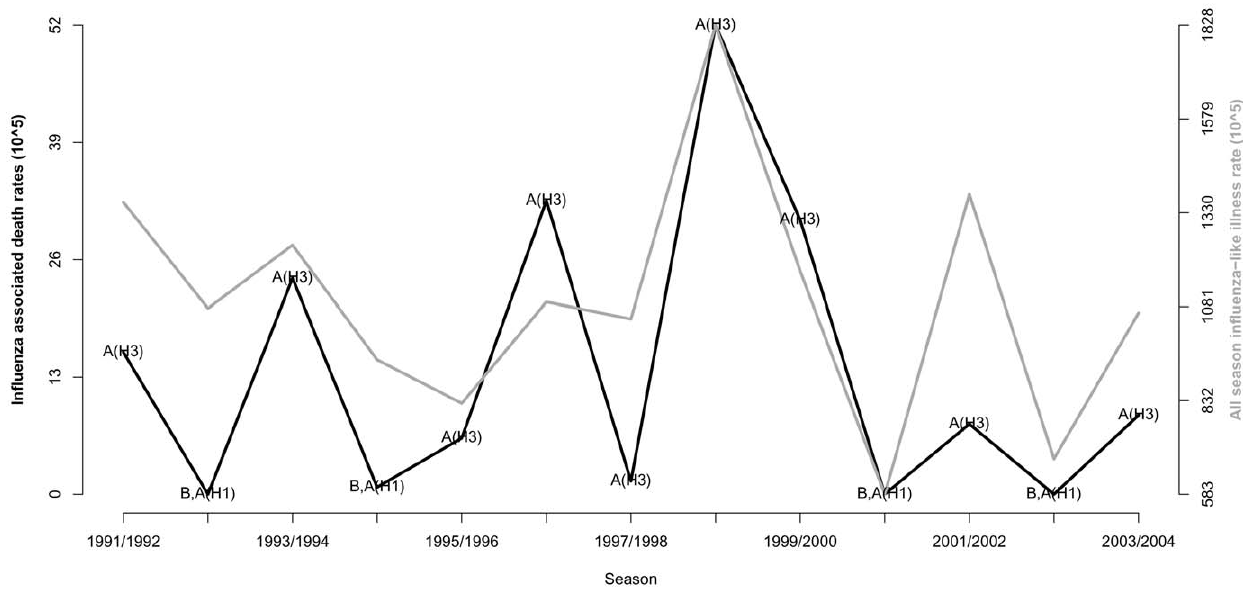
Figure 3. Association between seasonal rates of excess pneumonia and influenza (P&I) and seasonal rates of influenza like illnesses in the elderly population over 65 yrs.